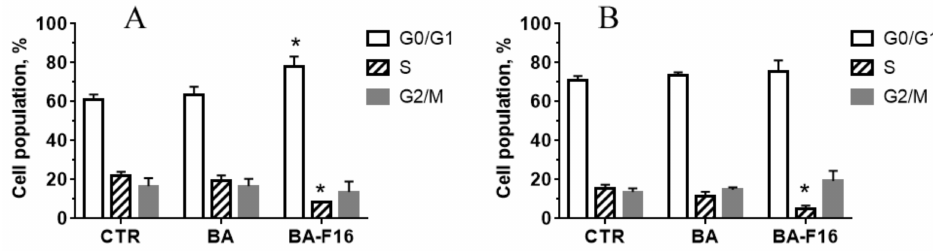
Figure 3. MCF-7 ( A ) and HF ( B ) cell cycle analysis after 24 h incubation with BA (5 µ M) and BA–F16 (1 µ M). Data are mean ± SD of three independent experiments. (* indicates p < 0.05 when compared with